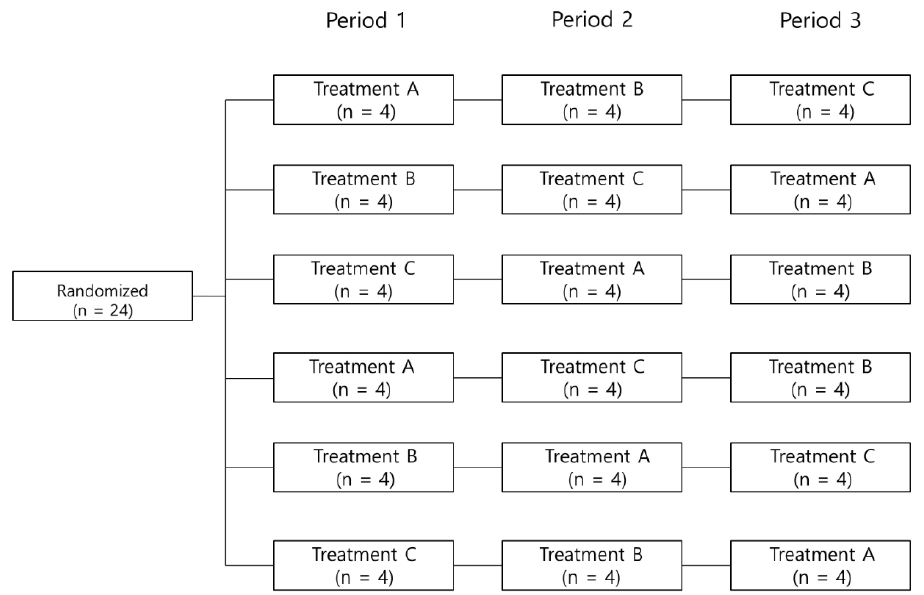
Figure 1. Study design. Subjects ( n = 24) were randomized to one of the six sequence groups (four in each sequence in period 1). Subjects were administered the study drugs for 5 days with a 10-day washout between treatments.